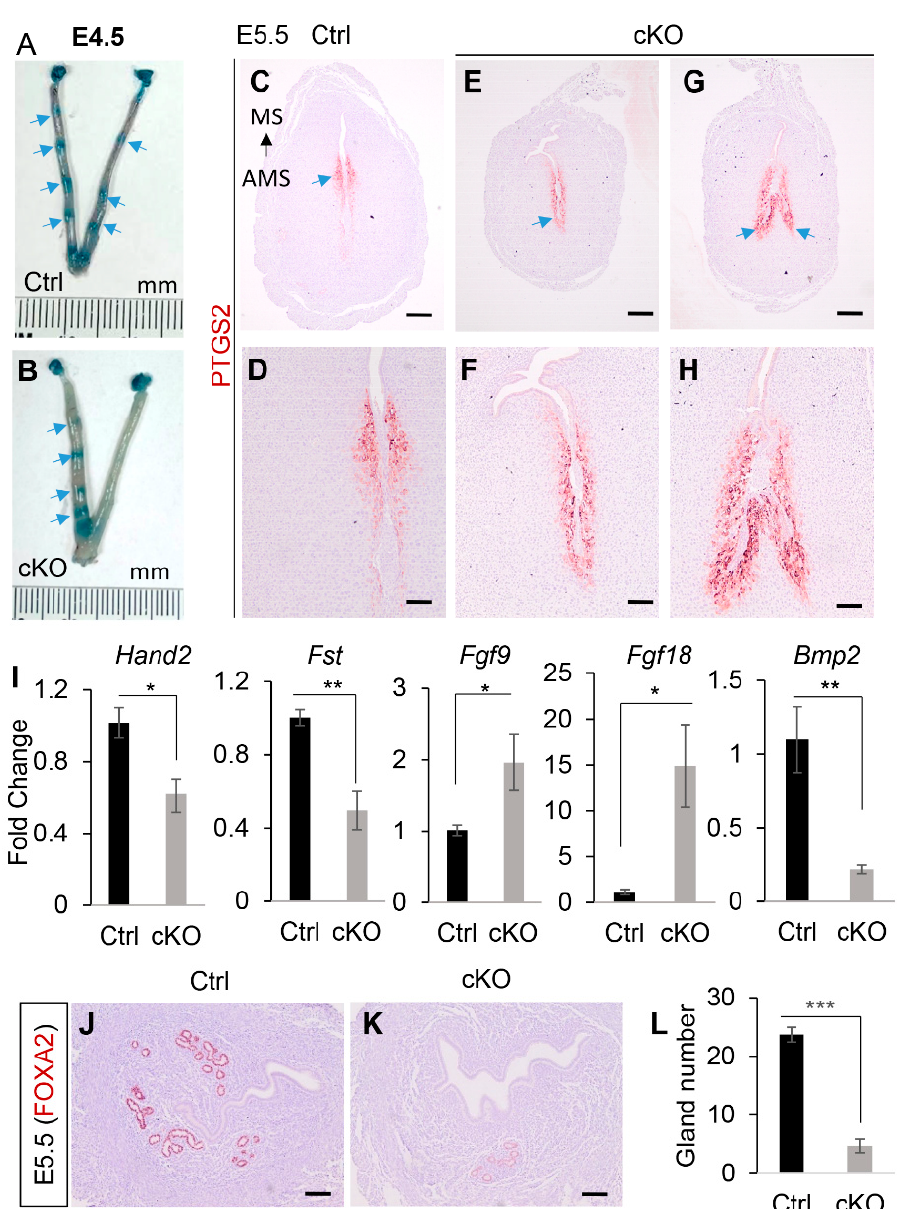
Figure 6. Abnormal implantation in Ezh2 Amhr2 -Cre cKO mice. ( A , B ) Chicago blue injection of control and Ezh2 Amhr2 -Cre cKO mice at E4.5. Arrows indicate implantation sites. ( C – H ) Immunostaining of PTGS2 using uteri from control and Ezh2 Amhr2 -Cre cKO mice at E5.5. Panels ( D , F , H ) are higher power images for panels ( C , E , G ), respectively. Arrows indicate the location of PTGS staining. MS, mesometrial side. AMS, antimesometrial side. Scale bar = 100 µ m ( D , F , H ) and 250 µ m ( C , E , G ). ( I ) qRT-PCR analysis of Hand2 , Fst , Fgf9 , Fgf18 , and Bmp2 using implantation sites from control and Ezh2 Amhr2 -Cre cKO mice at E4.5. n = 6. Data are mean ± s.e.m, * p < 0.05 and ** p < 0.01. ( J , K ) Reduced numbers of FOXA2-positive uterine glands in the inter-implantation sites of Ezh2 Amhr2 -Cre cKO mice at E5.5. At least three animals for each genotype were examined. Scale bar = 100 µ m ( J , K ). ( L ) Quantification of the number of uterine glands. n = 3. Data are mean ± s.e.m, *** p < 0.001.